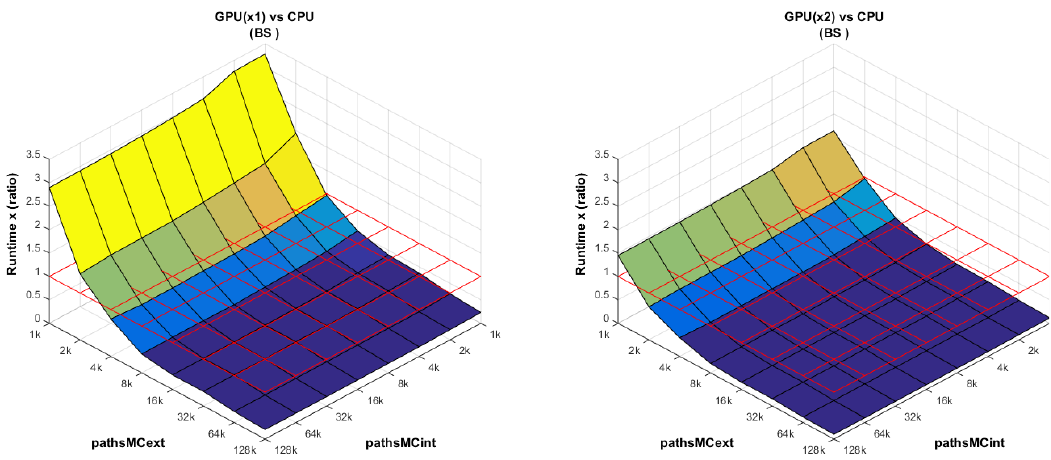
Figure 9. Runtime scaling: GPU(x1) vs. CPU (left), GPU(x2) vs. CPU (right) given as a ratio between platform X vs. platform Y ( X / Y ). The red-colored grid shows the point where both platforms would achieve the same runtime. Above this grid, runtime X is larger than runtime Y , and vice versa. GPU vs. PHI : Figure 10 (left) is a combination of the previously analyzed plots (Figures 8 and 9); whereas the XeonPhi has enough work items at pathsMCext = 1 k , the GPU requires a